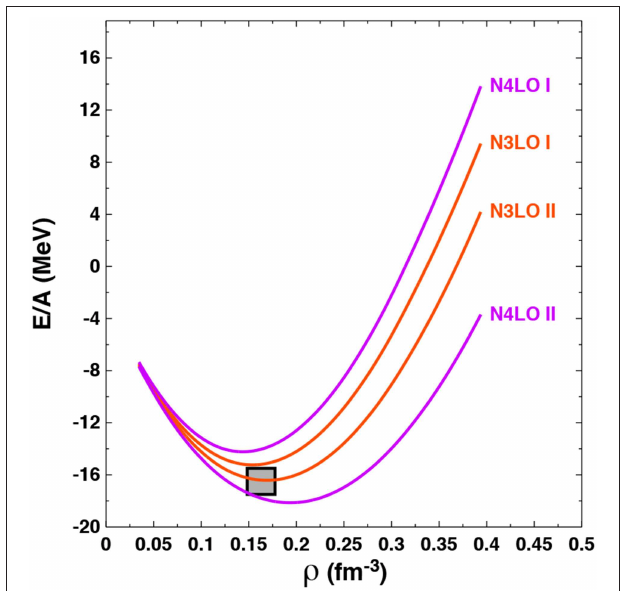
FIGURE 3 | Energy per particle in SNM as a function of density at N 3 LO and N 4 LO with a cutoff of 3 = 450MeV. For the 3NF contributions, the LECs of either Table 1 or Table 2 are applied as indicated by labels “I” or “II”, respectively. Case “II” is characterized by including the 2PE 3NF up to the given order. The approximate empirical saturation energy and density are indicated by the gray box.